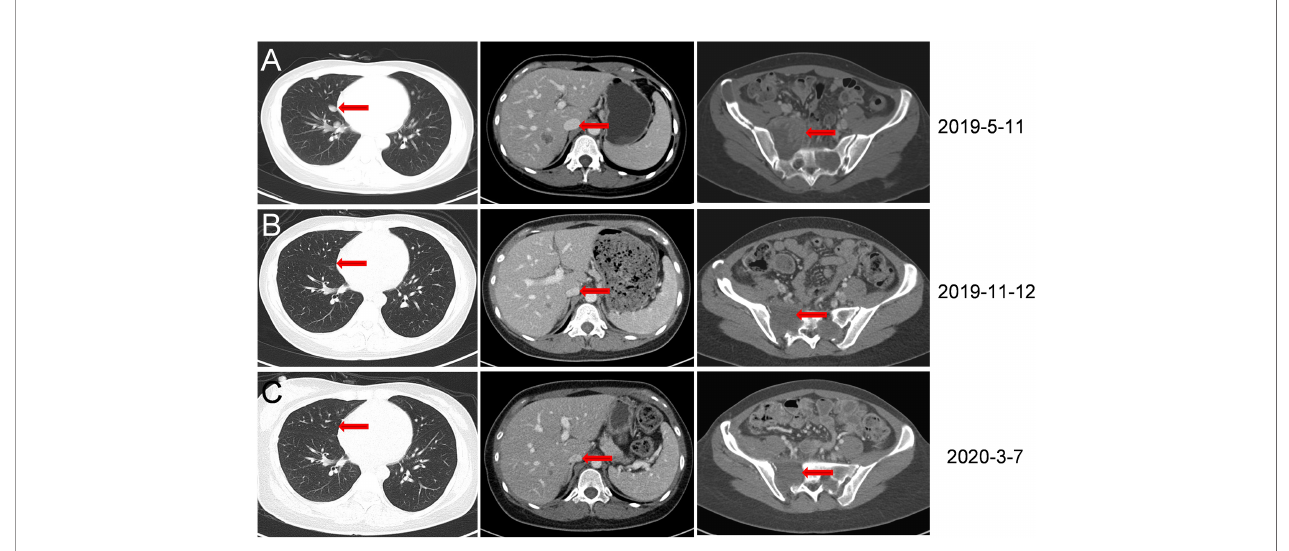
FIGURE 2 | CT scan images during treatment. (A) In May 2019, eight months following anlotinib treatment, new multiple lung metastases were observed. (B) In November 2019, six months following anlotinib combined with toripalimab treatment, lesions in the lung disappeared. Liver and sacral vertebrae metastases shrank. (Size was reduced from 5.5 cm × 5.4 cm to 3.5 cm × 3.8 cm). (C) In March 2020, CT re-examination indicated stable